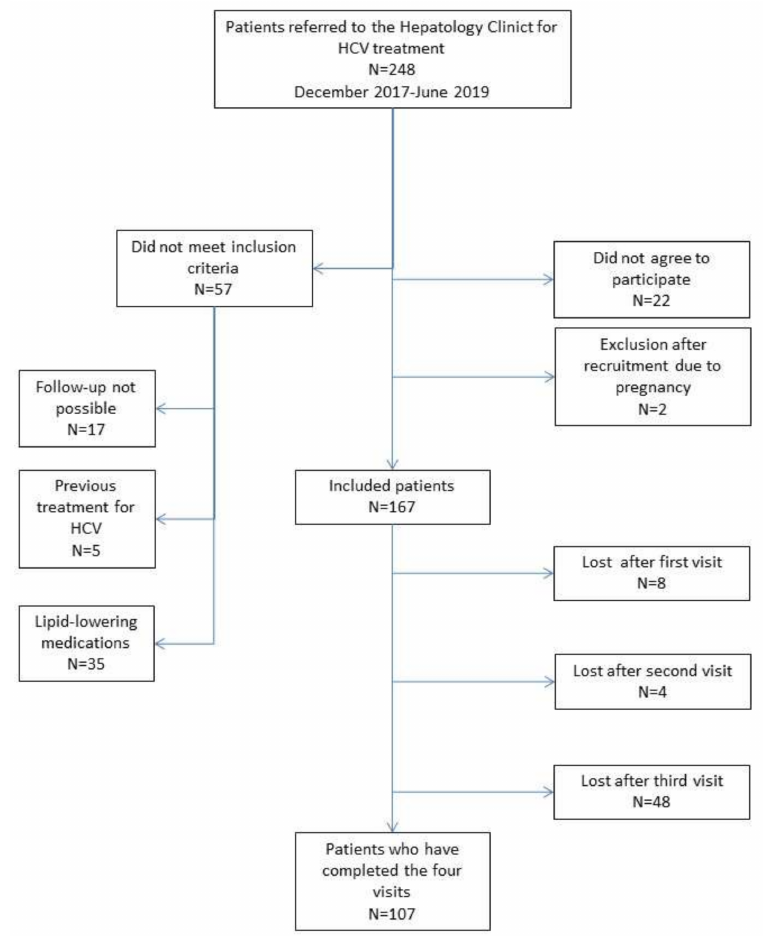
Figure 1. Patients’